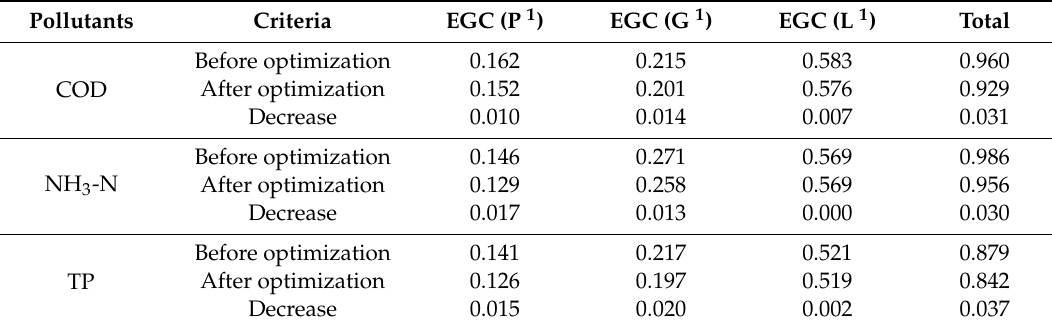
Table 4. EGC S of multiple criteria in the Xian-jiang